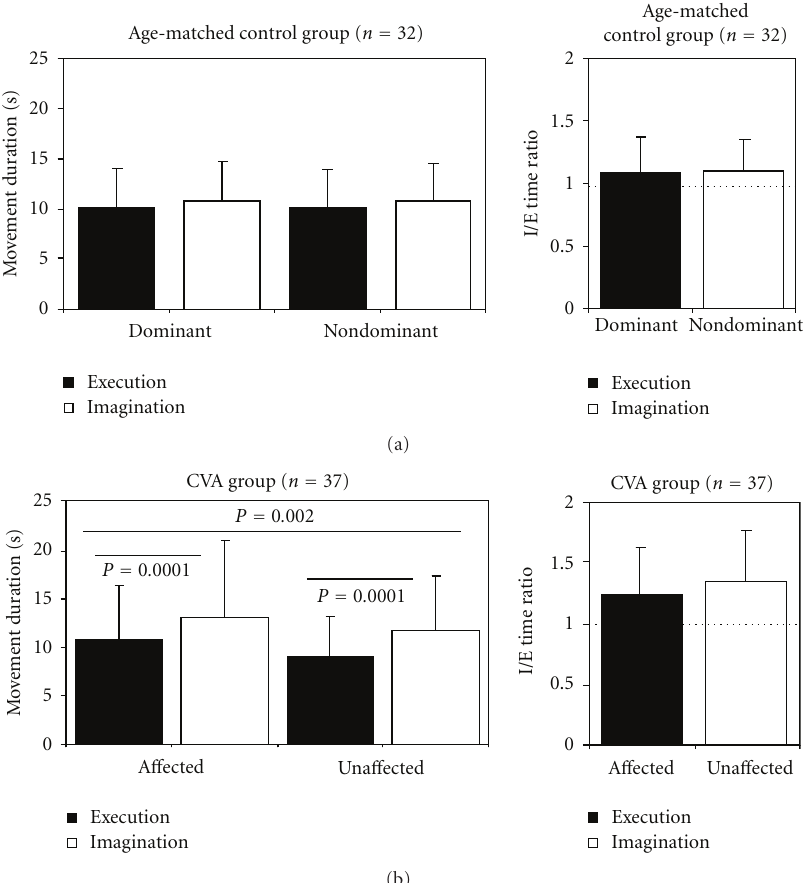
Figure 1: (a) Mean duration (1SD) of stepping movements during physical execution and mental simulation conditions (left panel) and imagination/execution time ratio of dominant and nondominant sides in age-matched healthy individuals. Similar duration during both conditions (temporal equivalence) yielding I/E time ratio near 1. (b) Similar illustration as in (a) for the stroke group. Longer stepping movement times during the imagination compared to the execution condition in individuals with stroke (total group); I/E time ratios above 1 indicating a lack of temporal congruence. Dotted lines indicate temporal congruence of 1 to